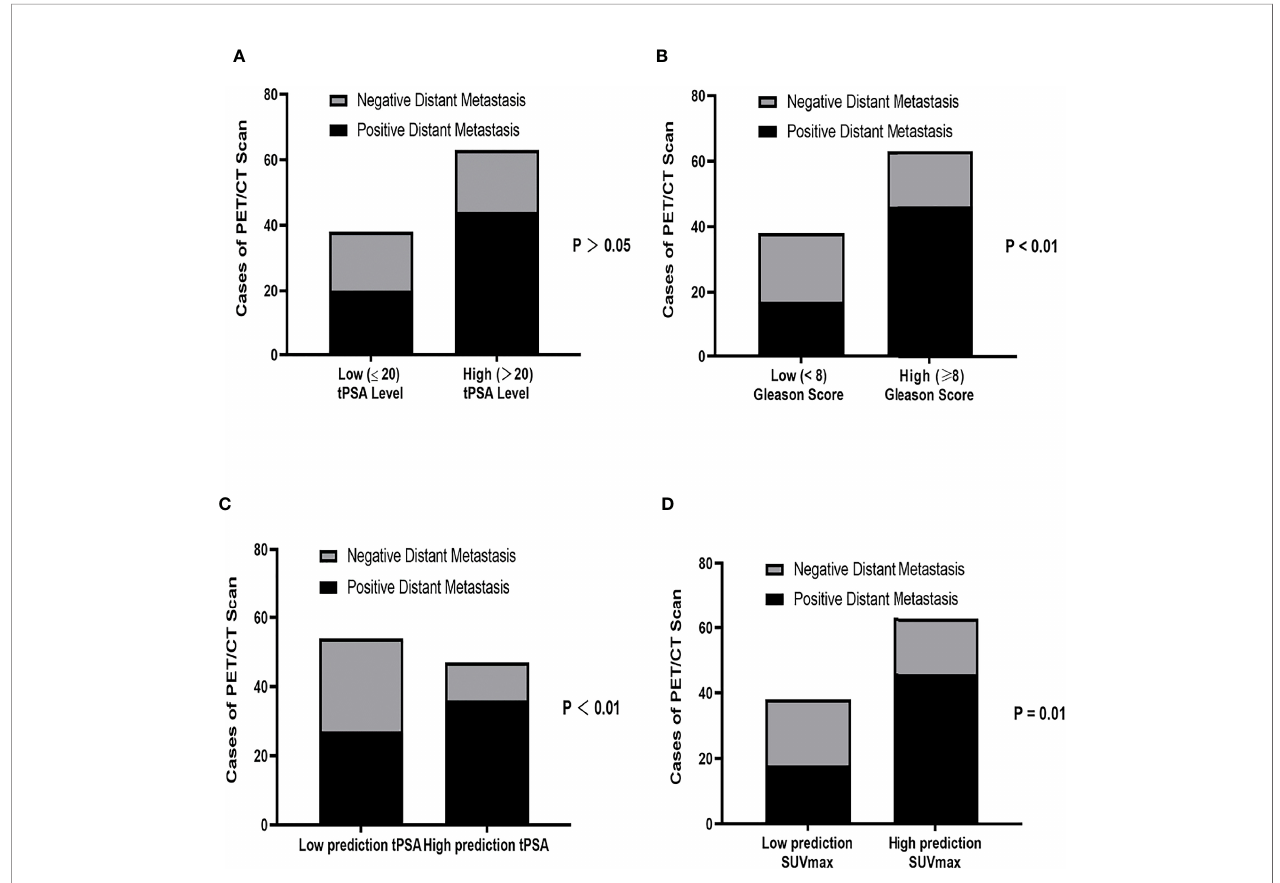
FIGURE 4 | Correlation between (A) tPSA level (tPSA high: >20 ng/mL vs tPSA low: ≤ 20 ng/mL), (B) Gleason Score (low-intermediate: <8 vs high: ≥ 8), (C) Prediction tPSA level (tPSA<29.01 ng/mL vs tPSA ≥ 29.01 ng/mL) and (D) Prediction SUVmax (SUVmax ≤ 13.76 vs SUVmax>13.76) for positive distant metastasis fi ndings on 18F PSMA-1007 PET/CT. tPSA, total PSA; PCa, prostate cancer.